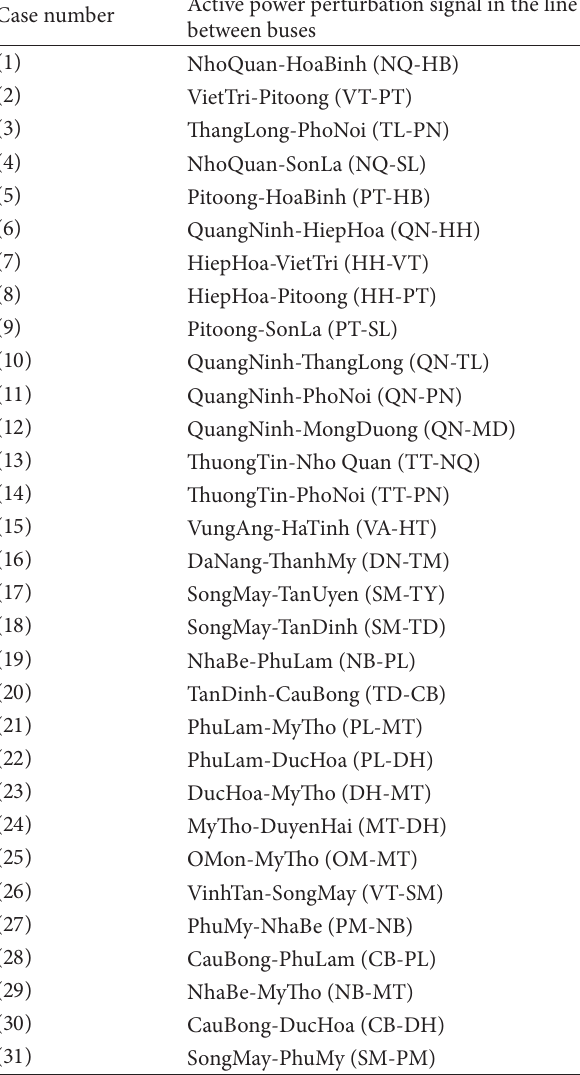
Table 3: Studied contingency cases.